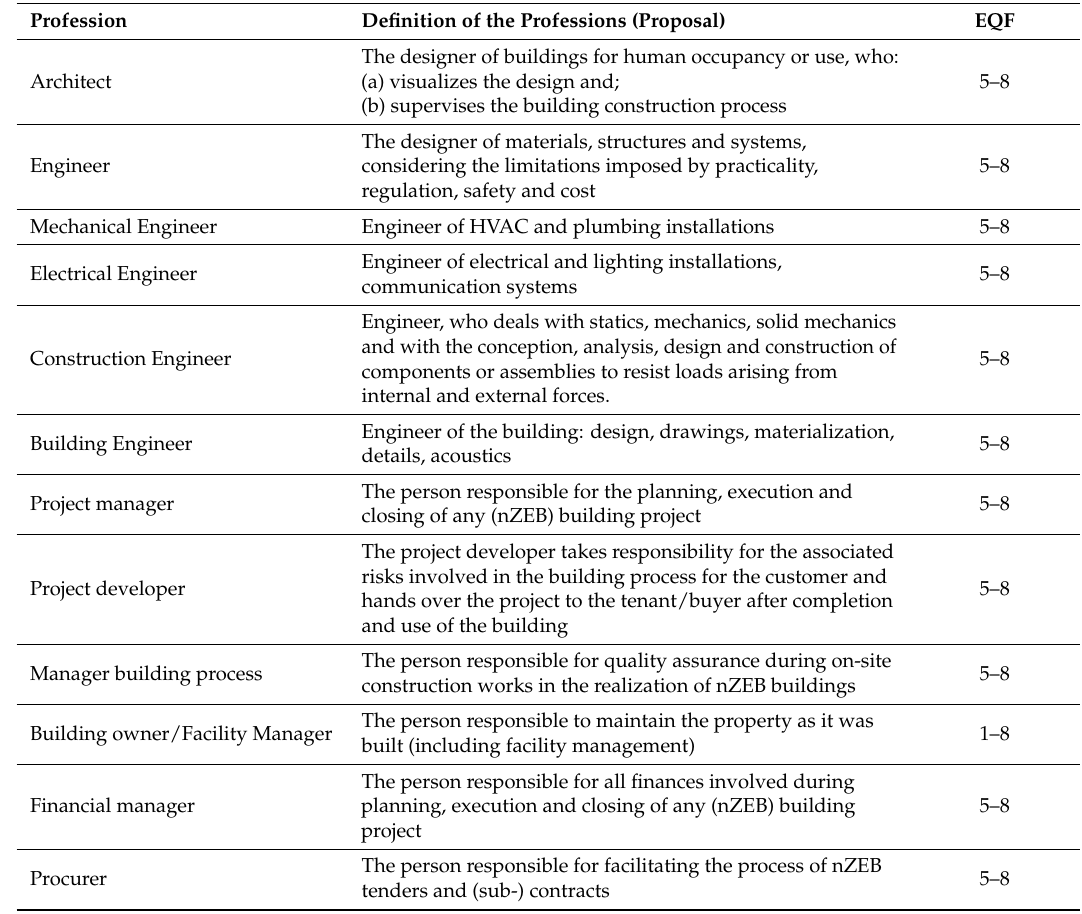
Table 2. Excerpt of the inventory of involved professions defined in